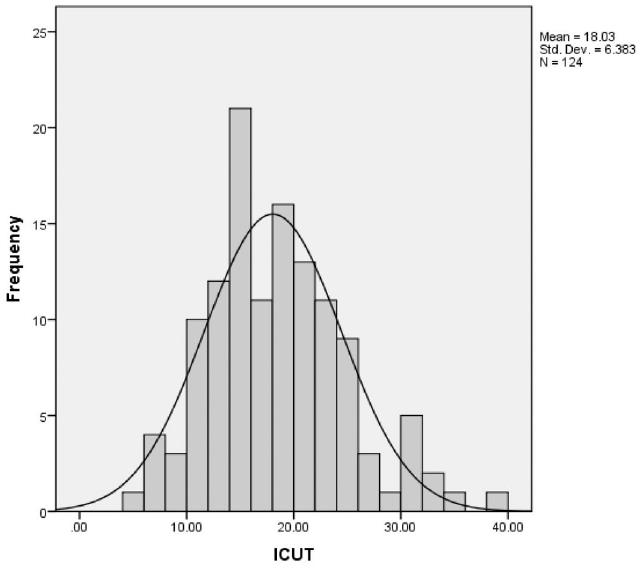
Figure 2. Distribution of CU trait scores on the